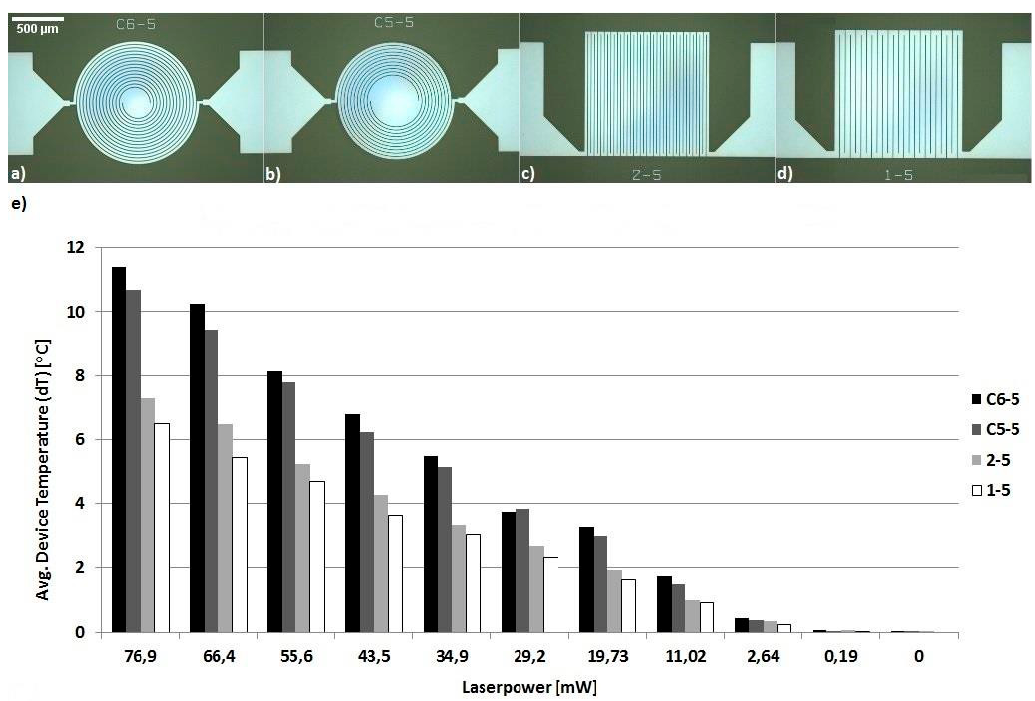
Figure 2. Different silver meander structures investigated ( a – d ). Responsivity of the four different structures at 4.17